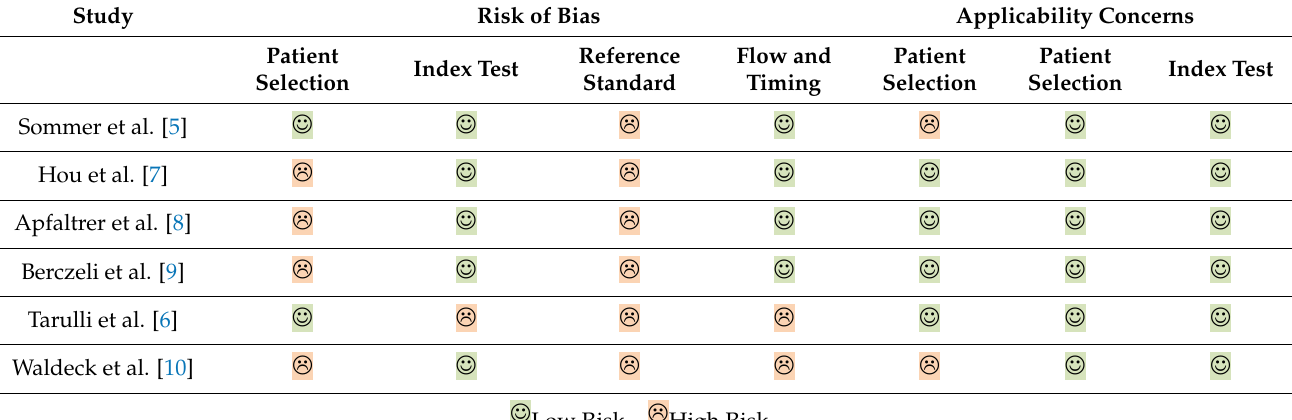
Table 4. Quality assessment of all articles.